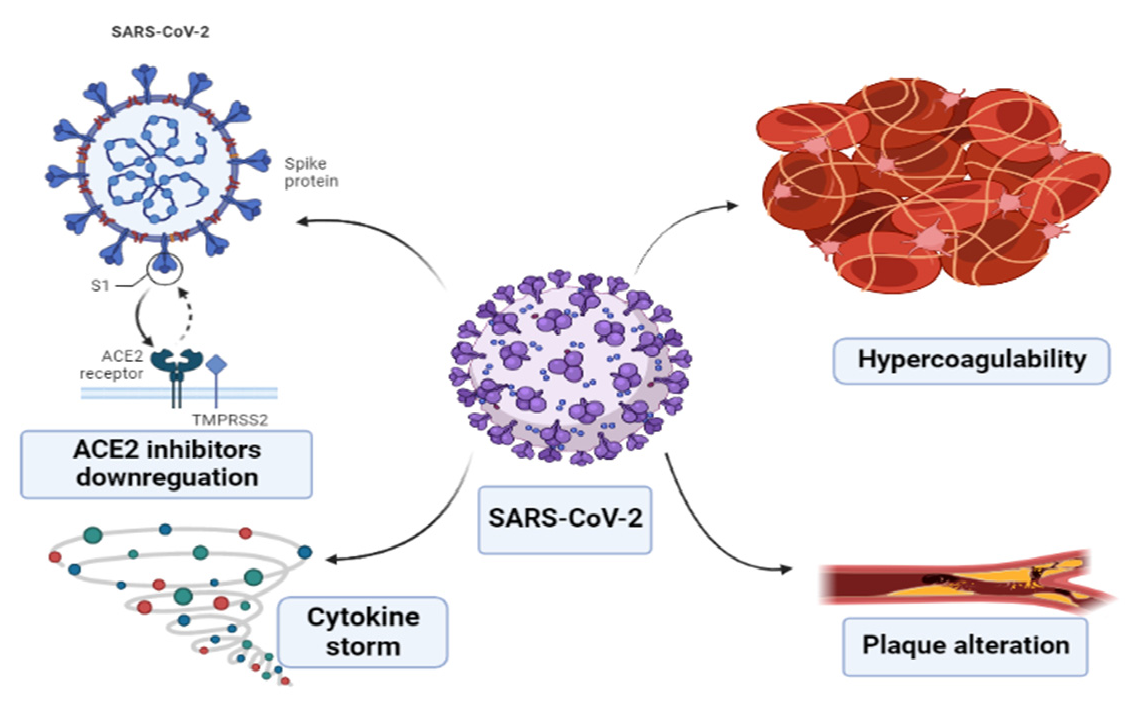
Figure 6. The possible mechanisms involved in the development of COVID-19 cardiovascular com- plications.